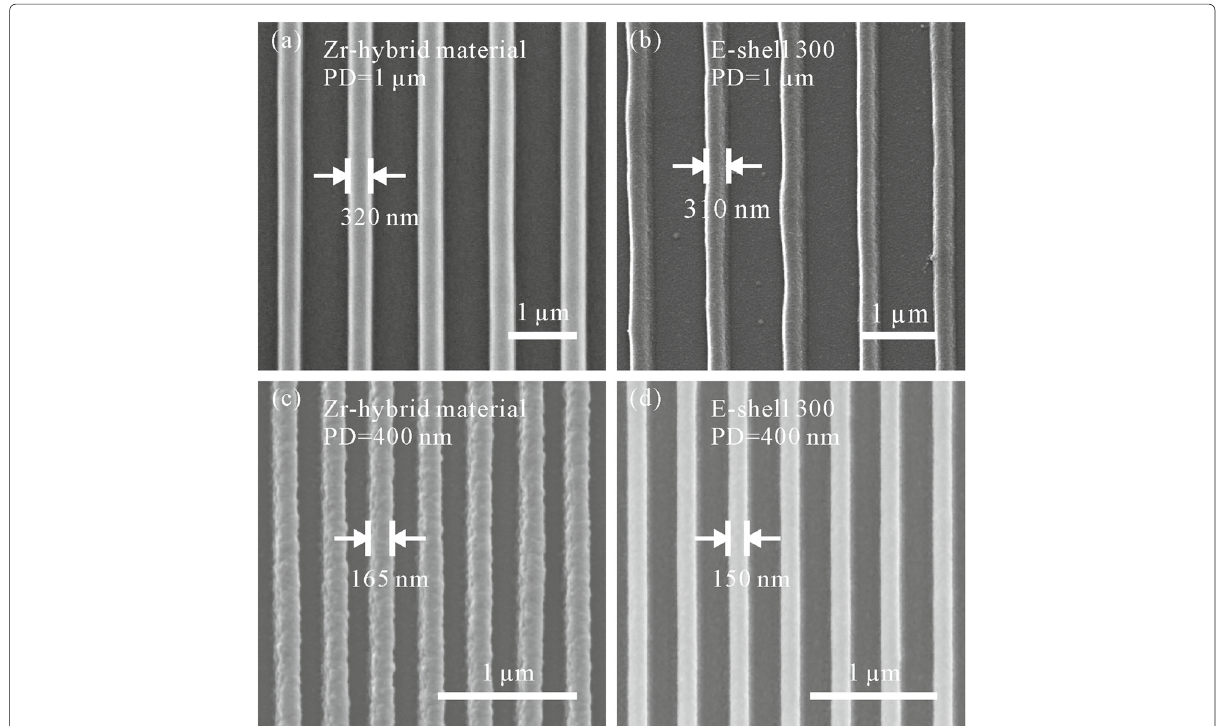
Fig. 4 SEM images of grating lines fabricated with different materials. The speed for the fabrication is 7 μ m/s. a Material: Zr-hybrid material; PD = 1 μ m; Laser intensity: 1.25kW/ μ m 2 . b Material: E-shell 300; PD = 1 μ m; Laser intensity: 1.02kW/ μ m 2 . c Material: Zr-hybrid material; PD = 400nm; Laser intensity: 0.69kW/ μ m 2 . d Material: E-shell 300; PD = 400nm; Laser intensity: 0.69kW/ μ m